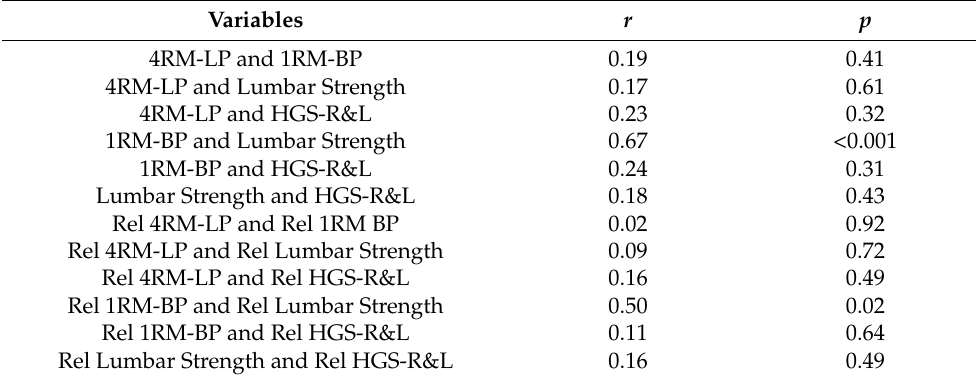
Table 3. Pearson correlation results with absolute and relative values (normalized to body weight). Variables r